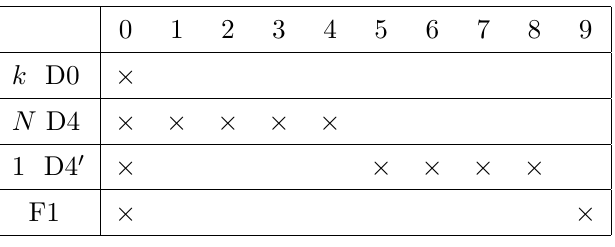
Table 1 . The directions of the various